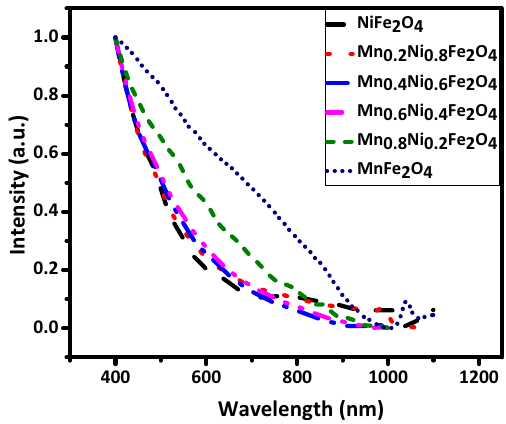
Figure 4. Absorption spectra of the Ni 1− x Mn x Fe 2 O 4 samples.